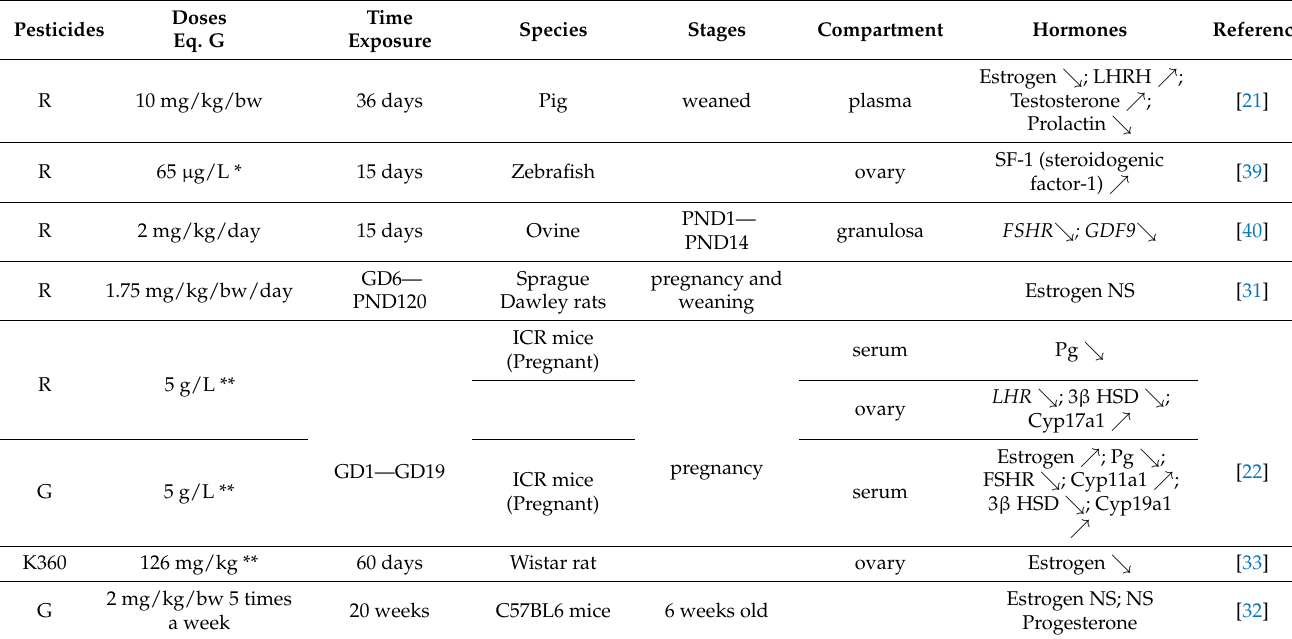
Table 2. Summary of in vivo studies on the impact of G or GBH exposure on steroidogenesis in females. Numbering in brackets indicates references.